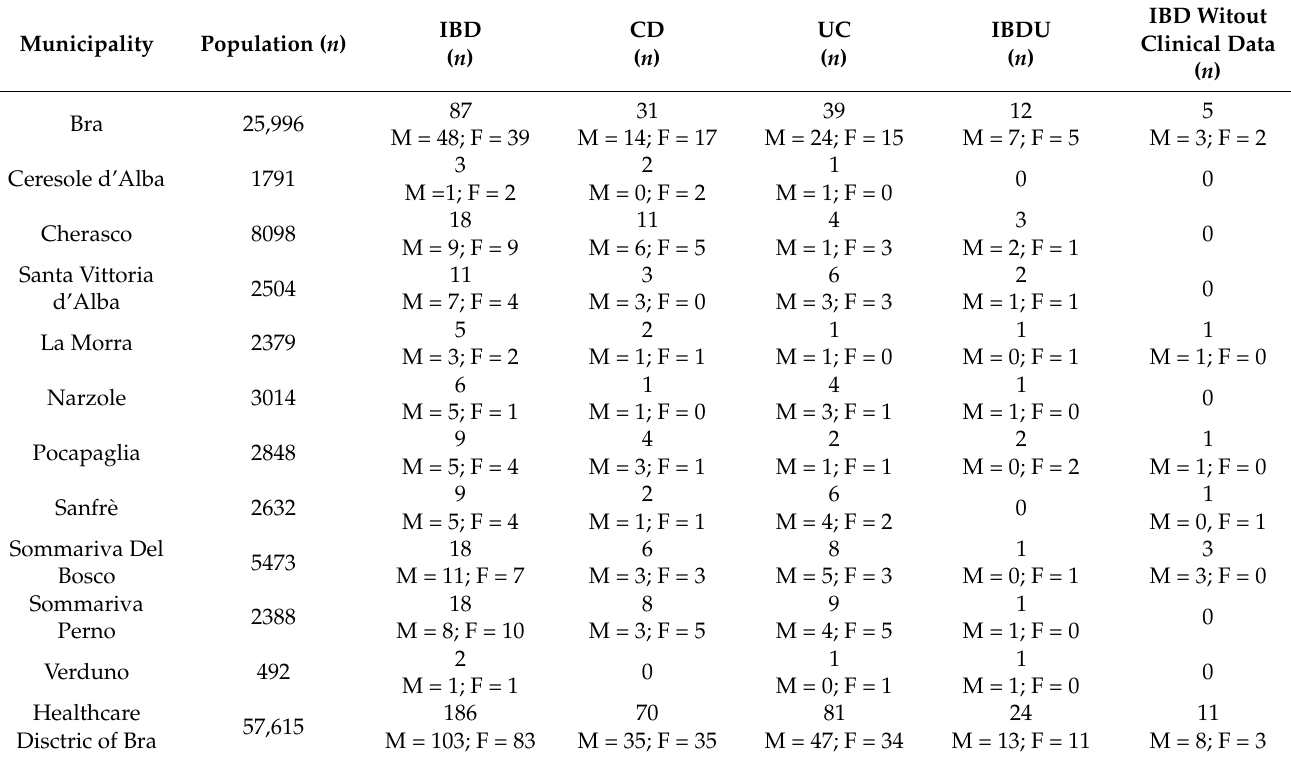
Table 1. Patients affected by IBD in the Healthcare District of